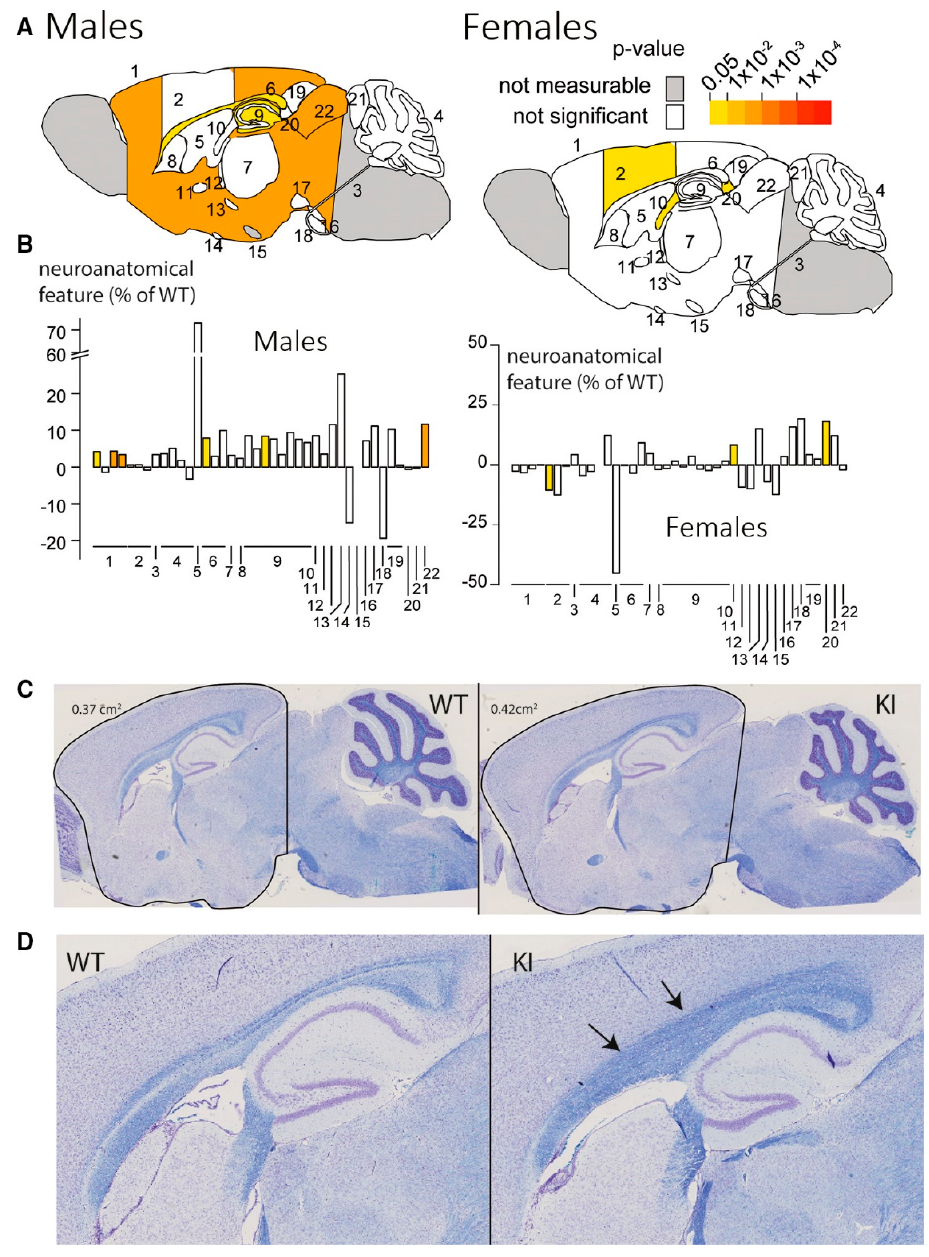
Figure 3. ( a − d ) Schematic illustration of brain morphology of male and female mice tested for Kcnq2 T274M/+ genotype (adapted with permission from [92], Wiley, 2022) 2.3. Brain Infections Any illness that damages the brain or spinal cord through microorganisms like vi- ruses, bacteria, fungi, or parasites is called a brain infection. Brain infections are dangerous and may be fatal. Swelling can result from the immunological activation brought on by illnesses and infections that affect the brain and spinal cord [62,109,110]. Fever, headache, seizures, behavioural abnormalities, and dementia are just a few of the symptoms that these illnesses and the ensuing infection can cause. In severe circumstances, they may cause mortality, head trauma, or a haemorrhage [10,111,112]. There are several kinds of